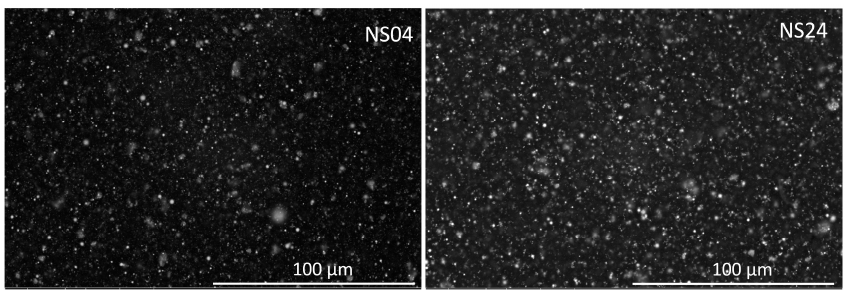
Figure 11. SEM image of NS04 and NS24 samples.